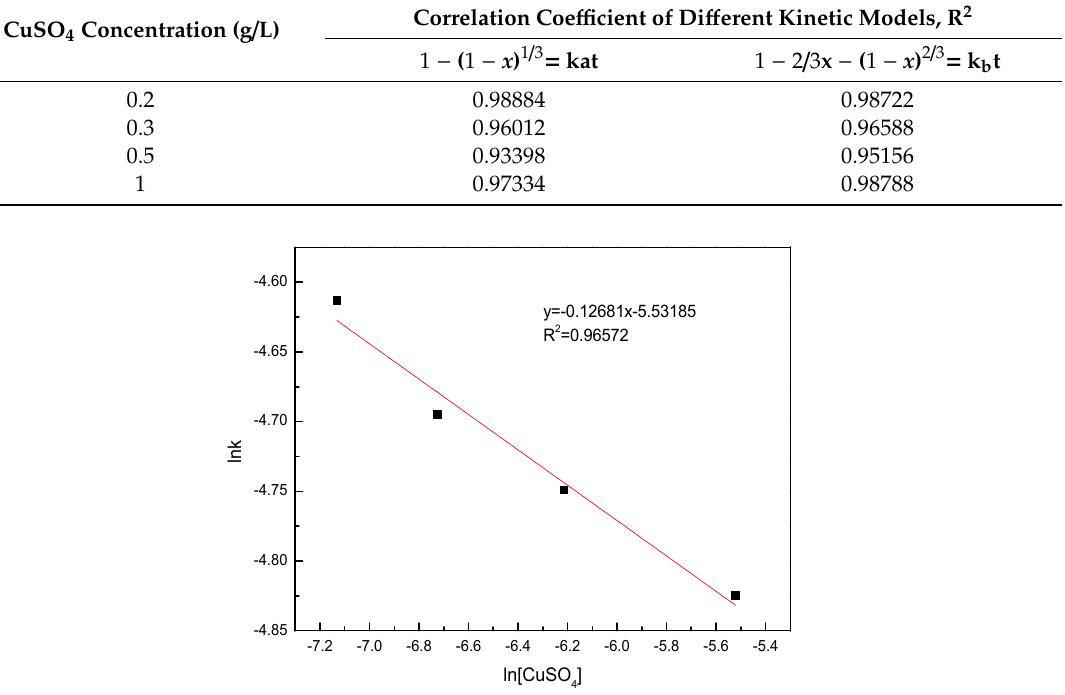
Figure 11. Plot of lnk vs. lnC CuSO4 for the determination of reaction order.